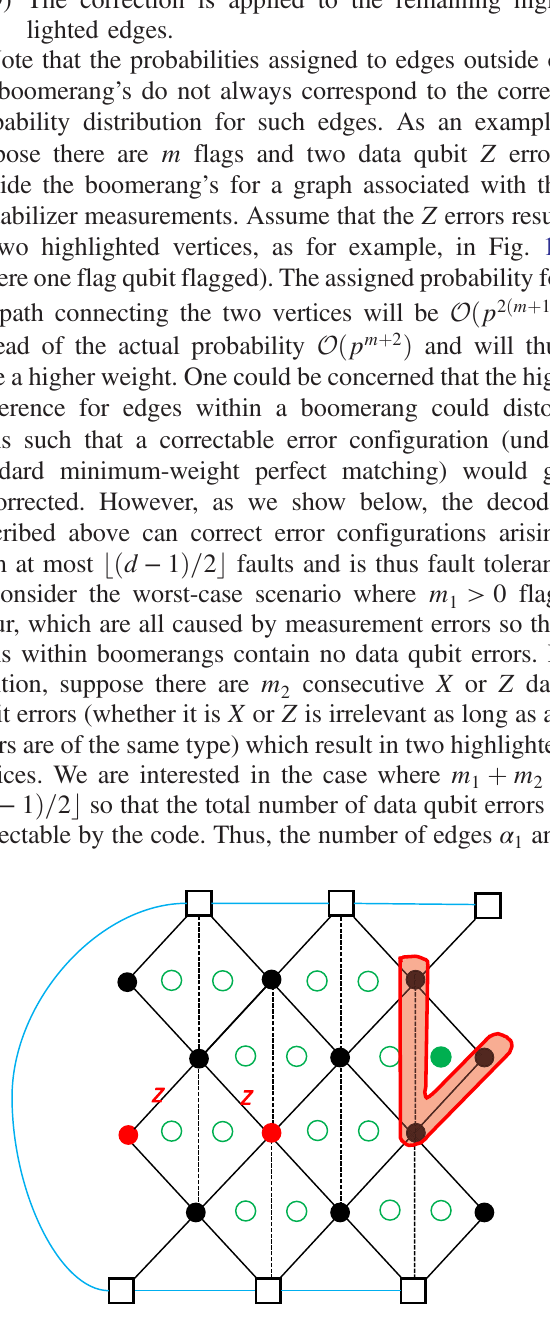
FIG. 13. Example of two Z errors resulting in two highlighted vertices for the graph G . In addition, we consider the case where X another fault occurs which results in a flag as shown in the